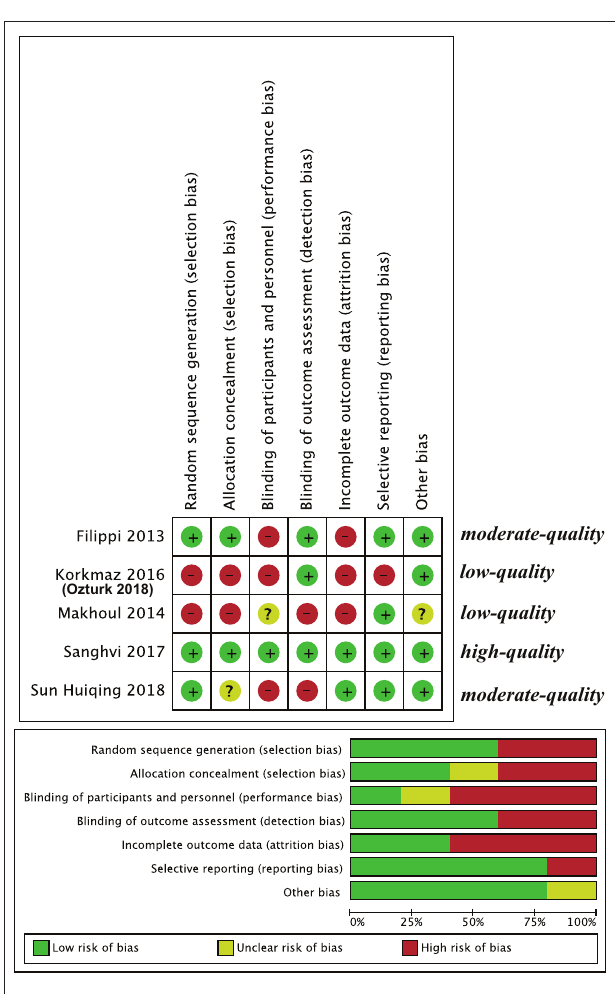
FIGURE 2 | Risk of bias